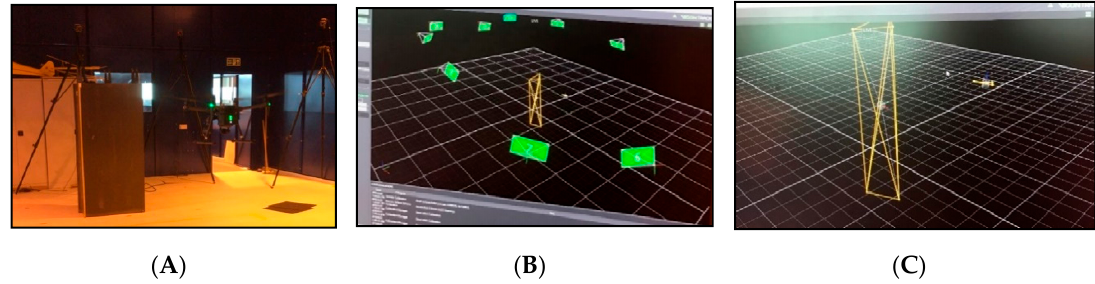
Figure 20. ( A ) DJI M210 inspecting the composite wing. ( B ) Vicon tracking system. ( C ) The wing and the unmanned aerial vehicle (UAV) being tracked.